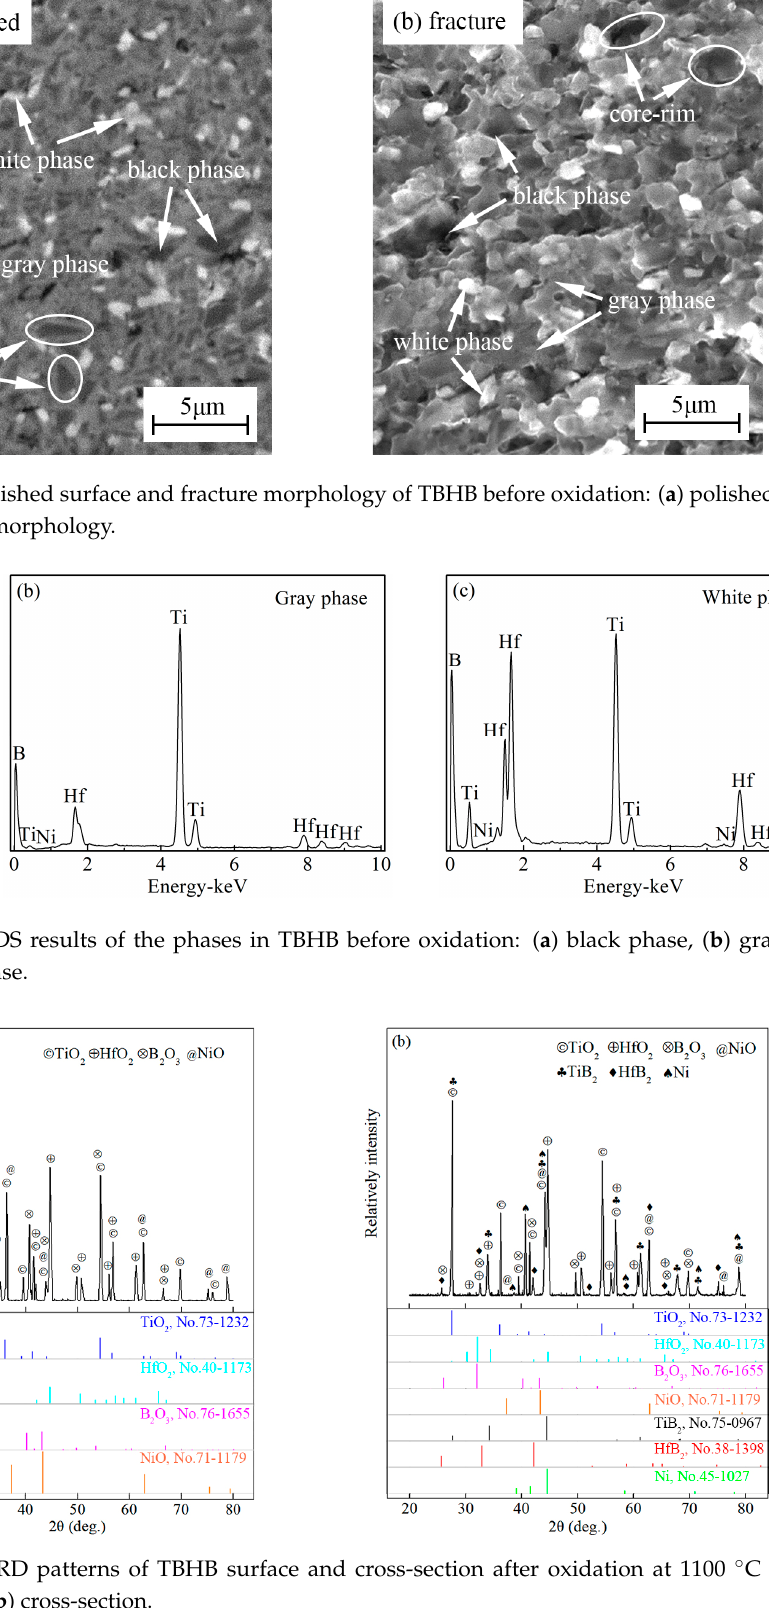
Figure 4. XRD patterns of TBHB surface and cross-section after oxidation at 1100 °C for 10 h: ( a ) surface, ( b ) cross-section.